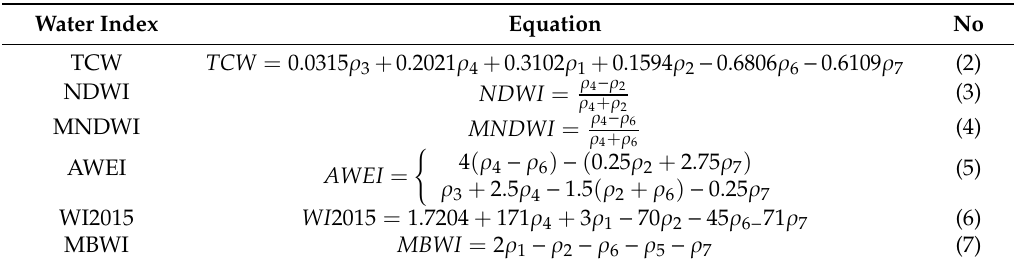
Table 3. Six commonly used water index